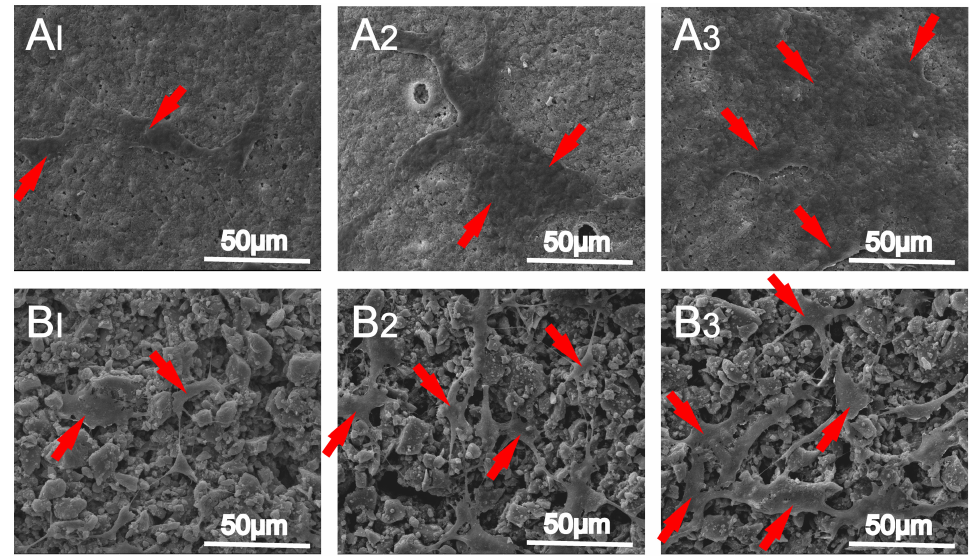
Figure 6. SEM images of hBMSCs attached on ( A ) MBG/SF and ( B ) MBG/PCL scaffolds for ( A1 , B1 ) 1, ( A2 , B2 ) 4, and ( A3 , B3 ) 7 days. The red arrows indicate cells. Reproduced from [105] under copyright CC BY